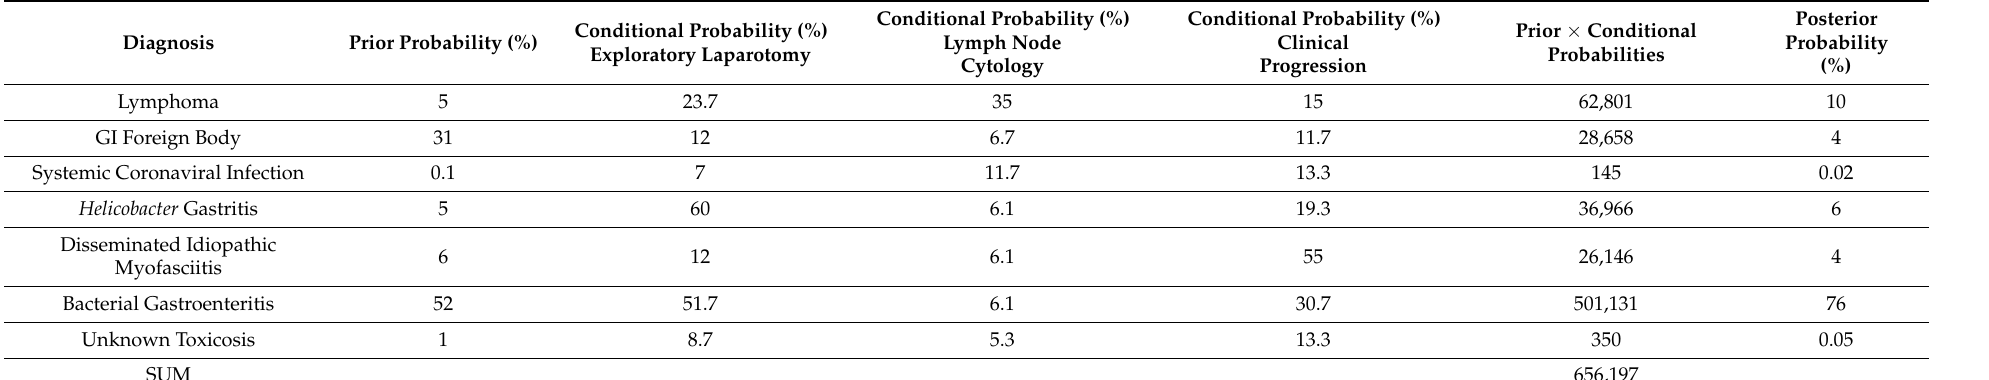
Table 2. Outside clinician-derived composite prior (posterior probabilities from Table 1 become prior probabilities due to a different reference time point) and conditional probabilities for differential diagnoses and diagnostic findings after all pre-surgical diagnostics in an approximately 1-year-old ferret presenting for two days of lethargy and inappetence, and one day history of diarrhea. Posterior probabilities of differential diagnoses at time of euthanasia are